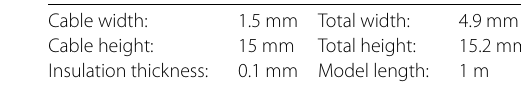
Table 1 Geometrical data of the stack of Rutherford cables (taken from [8]) Cable width: